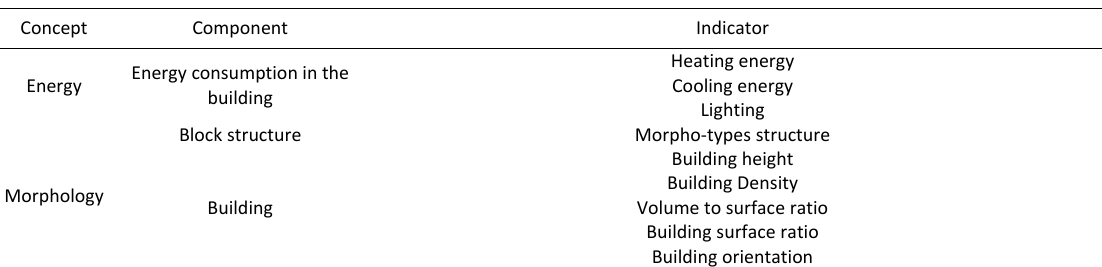
Table 1: Research framework of energy consumption mechanism of urban settlements with sustainable development approach Components, indicators in explaining the mechanism of energy consumption of urban settlements with a sustainable development approach with emphasis on morphology Concept